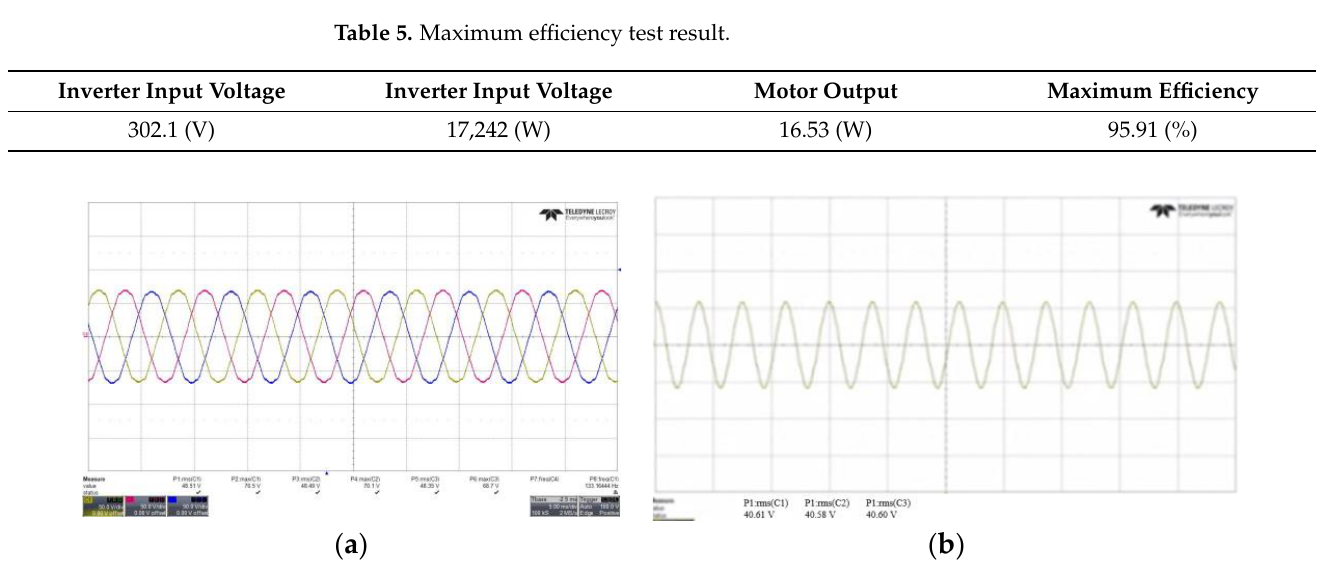
Figure 26. Measurement results of counter-electromotive force reduction rate according to the temperature of the final Dy-free magnet motor prototype: ( a ) measurement result of no-load counter-electromotive force at 25 °C; ( b ) measurement result of no-load counter-electromotive force at 150 °C. Table 6. Measurement result of back EMF reduction rate according to the temperature of the final